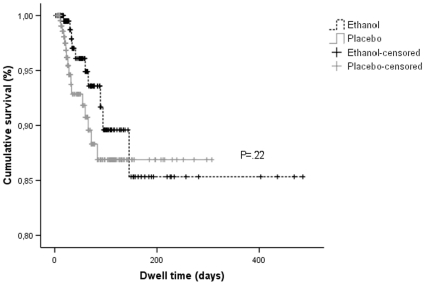
Kaplan-Meyer survival curves for comparison of the rate of catheter-related bloodstream infections.Data are presented as a function of catheter dwell time for patients treated with an ethanol lock (n = 226) or placebo.